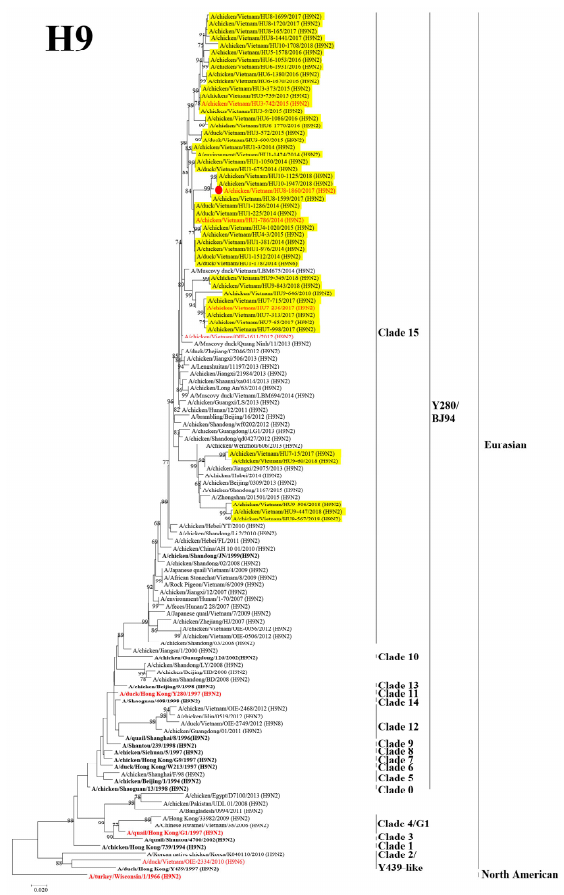
Figure 1. Phylogenetic tree of the HA gene segment of H9 avian influenza viruses. The HA gene segments of the H9 subtype viruses and of the reference strains was analyzed using maximum like ‐ lihood (ML) method using MEGA 7.0 software. The numbers at the nodes indicate the probability of the confidence levels from 1000 bootstrap replicates. The H9 viruses in this study are highlighted in yellow, the representative virus of each sublineage/clade is indicated in bold, the viruses selected for antigenic analyses are red highlight, the virus selected for pathogenicity assessment is indicated in the red circle. Based on the HA genes, the H6 viruses were phylogenetically classified into two lin ‐ eages: Eurasian and North American. Furthermore, the Eurasian lineage was divided into